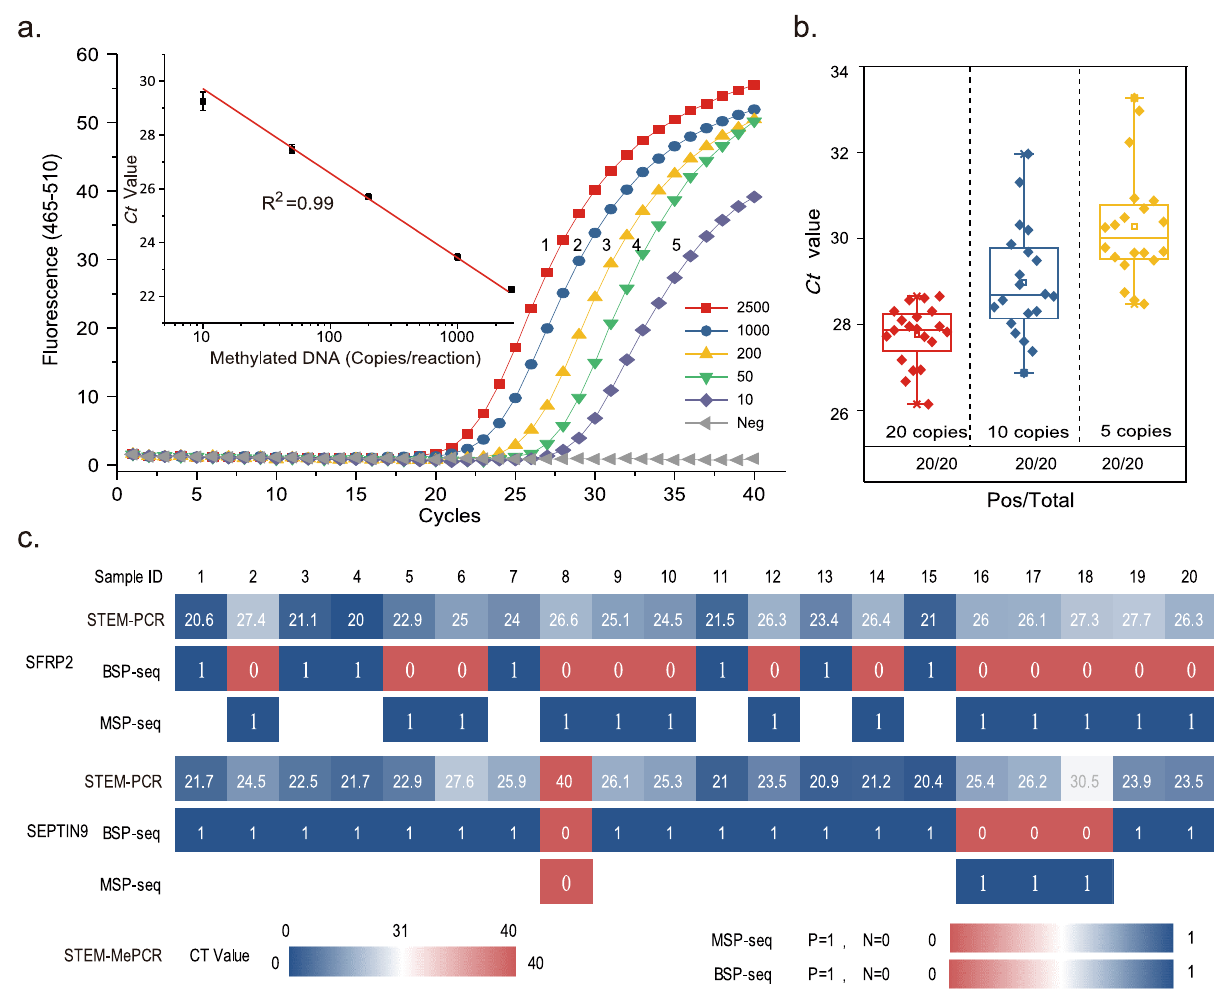
Fig. 3 | Performance of STEM-PCR for methylation detection. a Real-time ampli fi cation curve of STEM-PCRwith serially diluted templates (copies/reaction). (1) 2500 (red squares); (2) 1000 (blue disks); (3) 200 (yellow triangles); (4) 50 (green inverted triangles); (5) 10 (turquoise lozenges); (6) ddH 2 O as a negative control(graytriangles). Ct valueasafunctionoftemplateconcentrationand fi tted with linearregression ( R 2 =0.99) (inset).Data were the averageof three replicates, and error bars represent the standard deviation; b The results of 20 independent